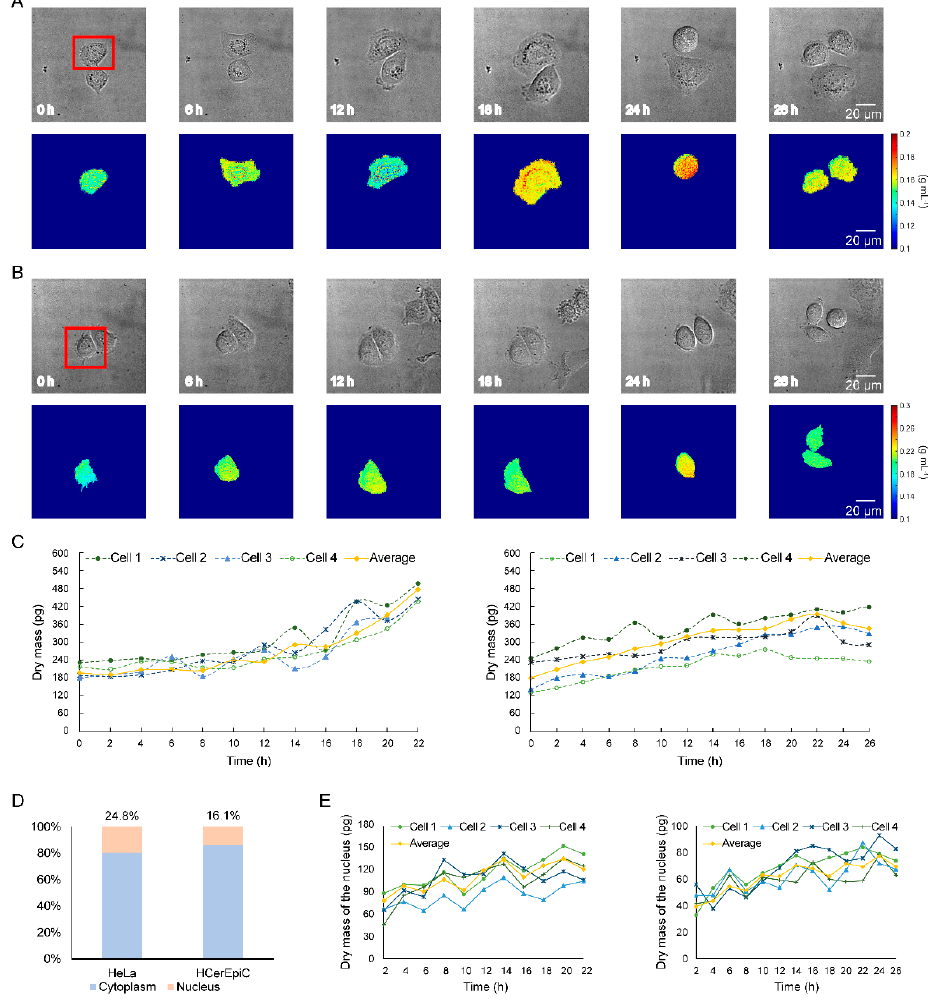
Figure 3. Long-term and quantitative dry mass monitoring of living HeLa cells and Human Cervical Epithelial Cells (HCerEpiC) during a cell cycle. Imaging results with DIC microscopy and reconstruction results with MWII for the single HeLa cell ( A ) and Human Cervical Epithelial Cell ( B ) indicated by a red box during a cell cycle. ( C ) Dry mass measurement and statistic results of single HeLa cells (left) and HCerEpiC (right) before M phase. The yellow curves represent the average dry mass measurement and statistic results of 98 HeLa cells and 101 HCerEpiC. ( D ) The average nuclear-cytoplasmic ratio of HeLa cells and HCerEpiC. ( E ) Dry mass of the nucleus for 4 single HeLa cells (left) and HCerEpiC (right). The yellow curves represent the average nuclear dry mass measurement and statistic results of 98 HeLa cells and 101 HCerEpiC. The values at 0 h were discarded due to the invisible